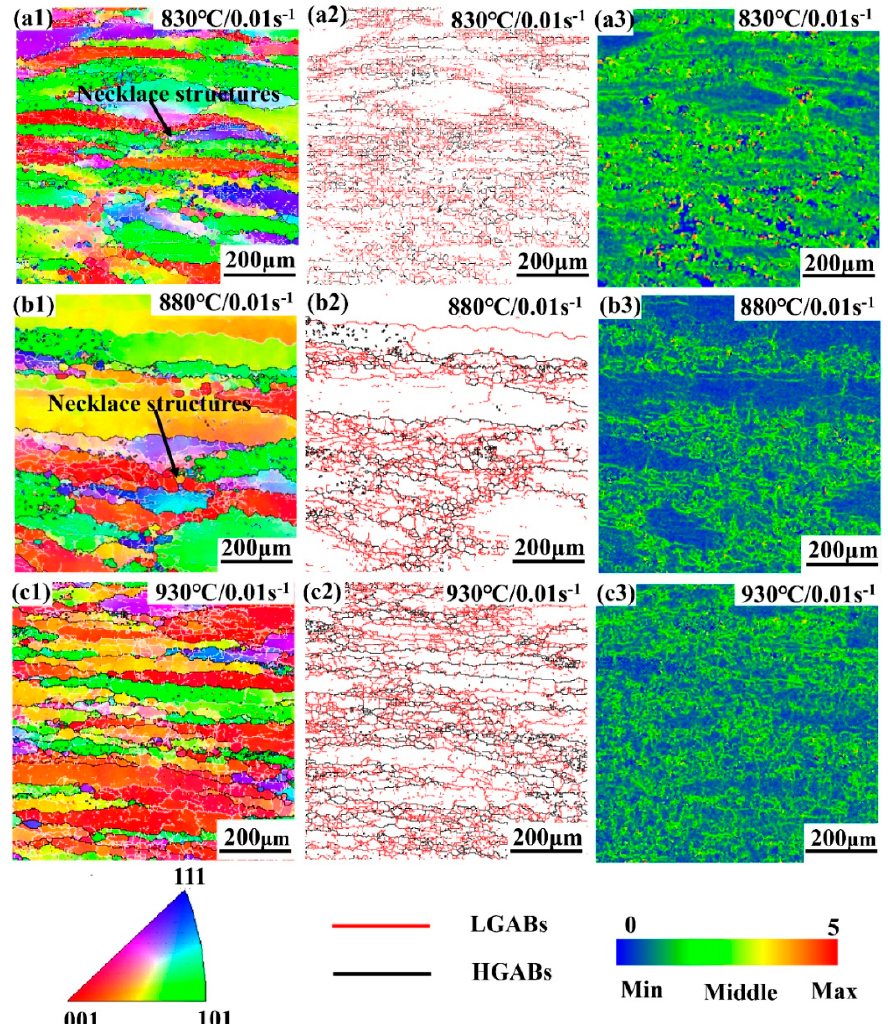
Figure 14. The EBSD analysis results of Ti-35421 alloy deformed at 0.01 s − 1 under different temperatures of the β phase region: ( a ) 830 °C, 0.01 s − 1 , ( b ) 880 °C, 0.01 s − 1 , ( c ) 930 °C, 0.01 s − 1 where the (1) is inverse pole figure, (2) is distribution of grain boundaries at high and low angle, and (3) is Kernel average misorientation under each condition.